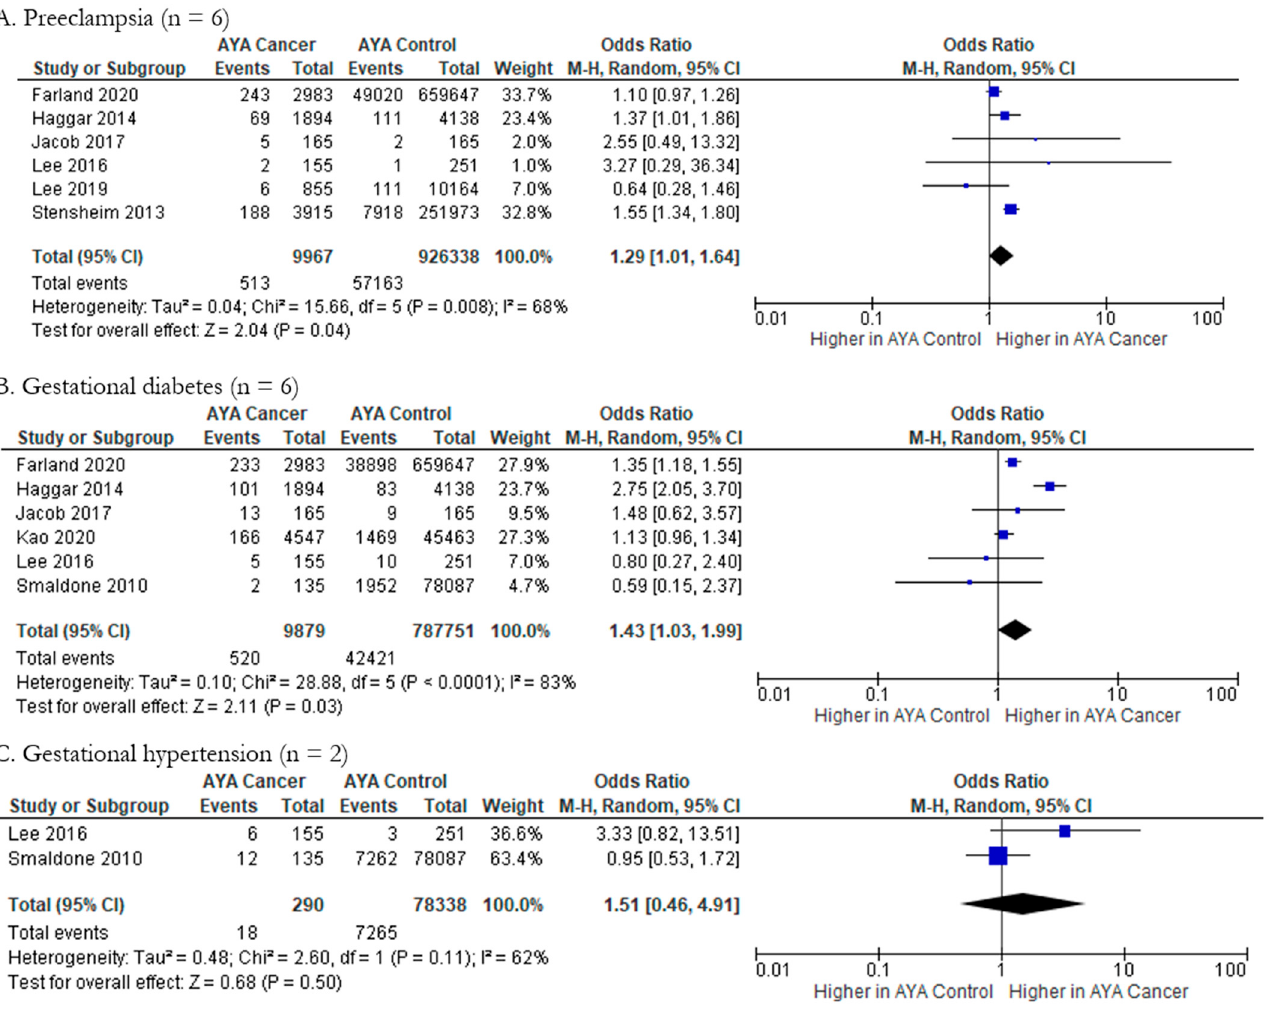
Figure 6. Forest plots for maternal health outcomes reported by two or more studies (n = 3). A.